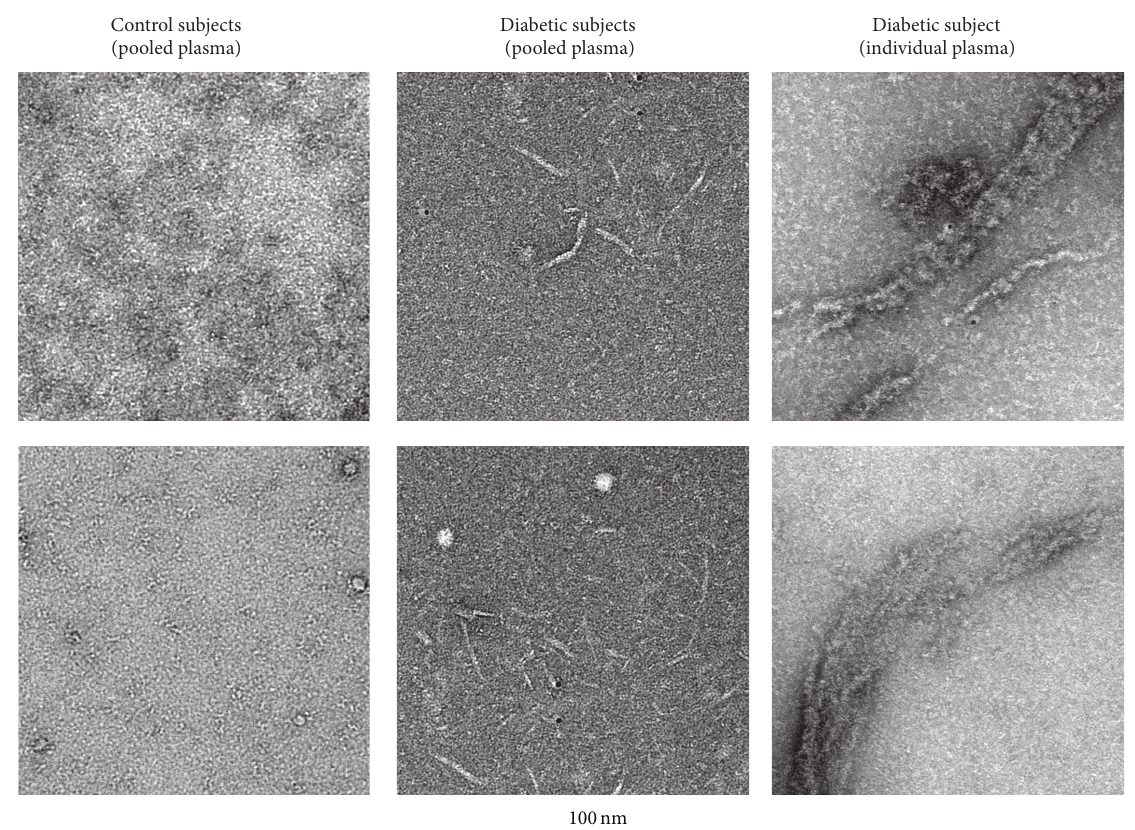
Figure 4: Electron microscopy of IgG purified from both pooled and single diabetic plasma and from pooled control plasma. Two representative images, taken from different fields in the same or separate pictures, are shown for each sample and treated as specified in Section 2. Homogeneous carpet of IgG distributed in overlapping layers with rare aggregates was the common feature of the control sample, whereas filaments of various dimensions were the characteristic shape adopted by IgG in diabetic plasma. Calibration bar is below images.